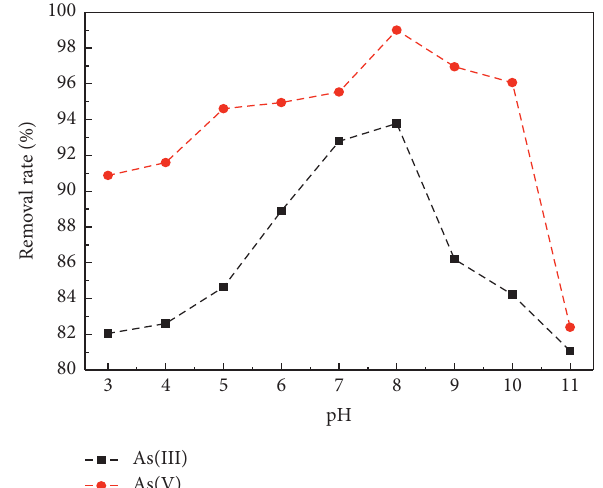
Figure 4: The effect of pH on arsenic removal at room temperature with reaction conditions: pH � 8, initial concentration: As(III) 70 μ g/L and As(V) 84 μ g/L, solution volume 25 ml, adsorbent dosage 0.05g, and ionic strength 0.01 mol/L.